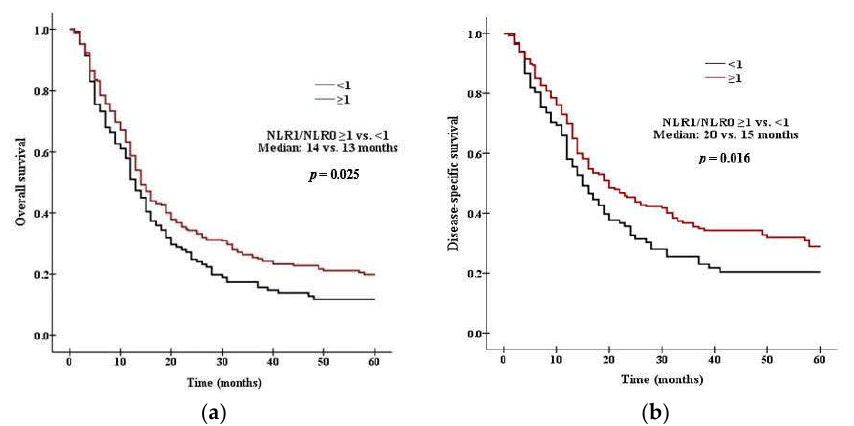
Figure 4. Kaplan–Meier curves of ( a ) OS in patients with NLR1/NLR0 ≥ 1 versus NLR1/NLR0 < 1, ( b ) DSS in patients with NLR1/NLR0 ≥ 1 versus NLR1/NLR0 < 1.